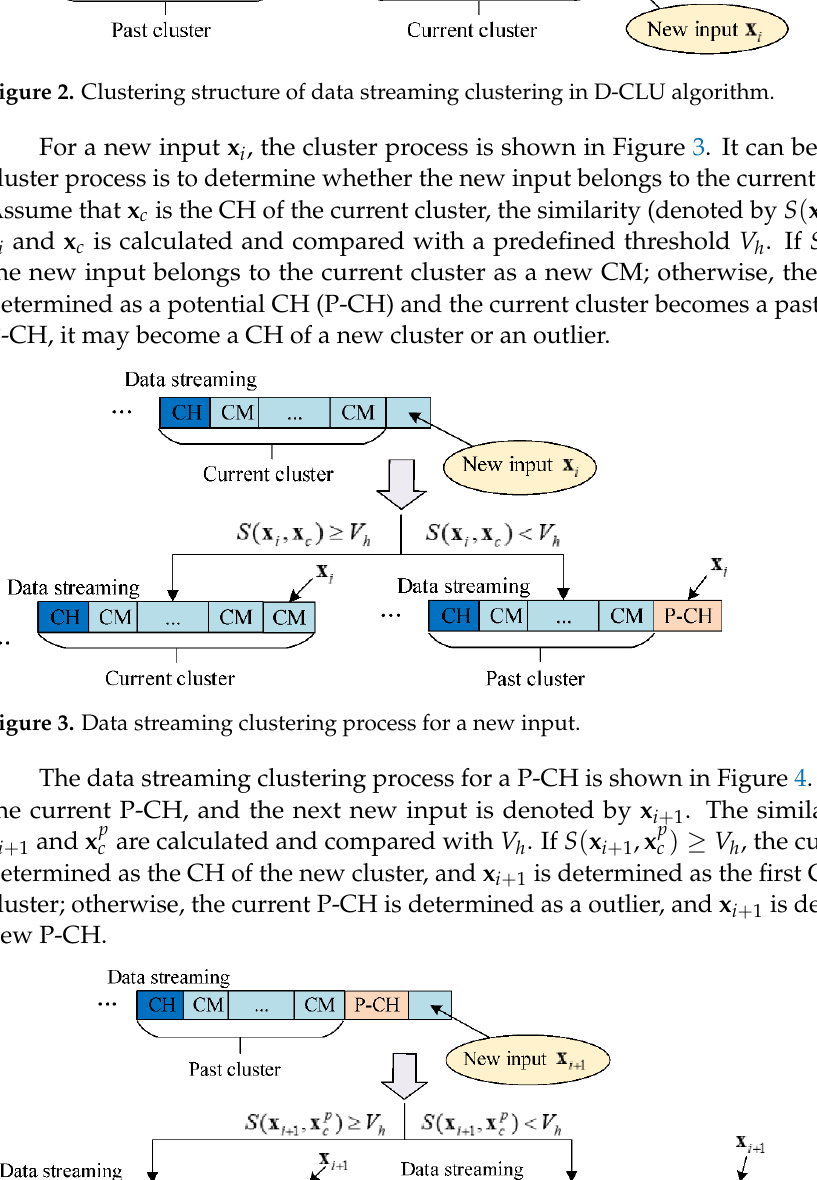
Figure 4. Data streaming clustering process for a P-CH.